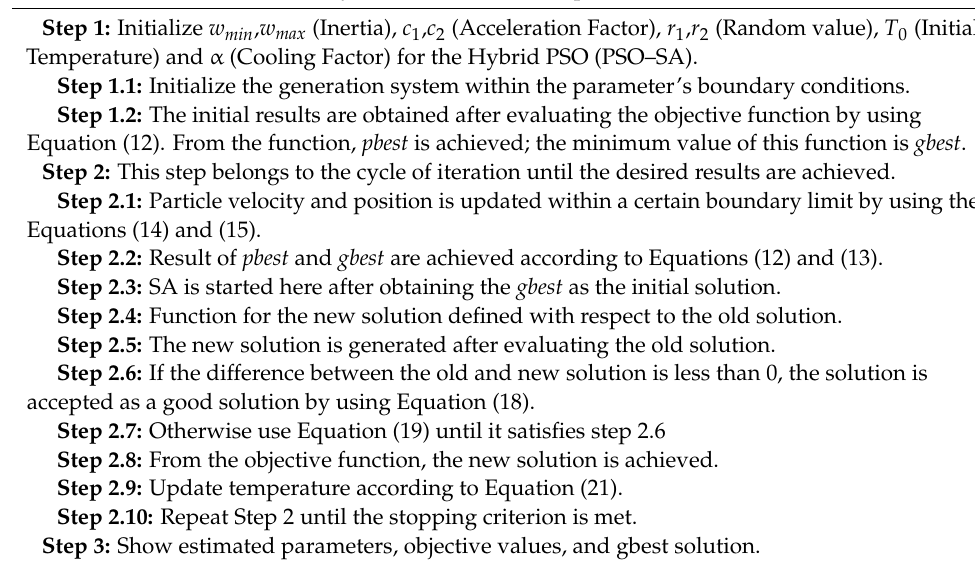
Algorithm 1 Pseudocode of Hybrid Particle Swarm Optimization